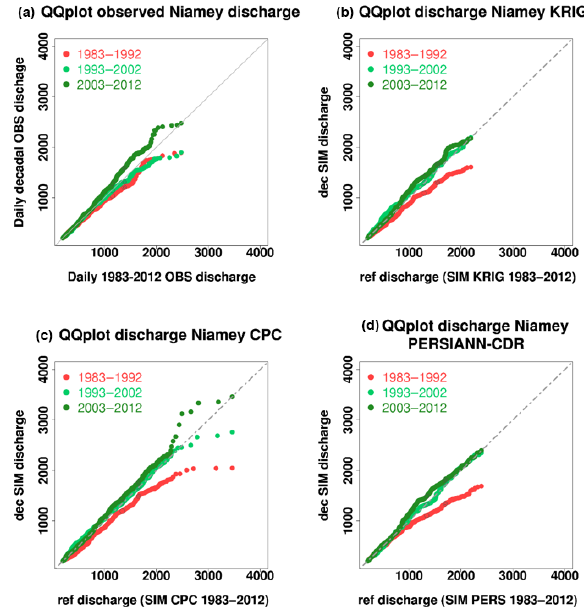
Figure 8. Quantile–quantile plot (Q–Qplot) of the distribution of daily discharge in Niamey (observed in a ; simulated in b, c, d ) for each decade, the reference ( x axis) is the red flood ob- served/simulated daily discharge between 1983 and 2012.